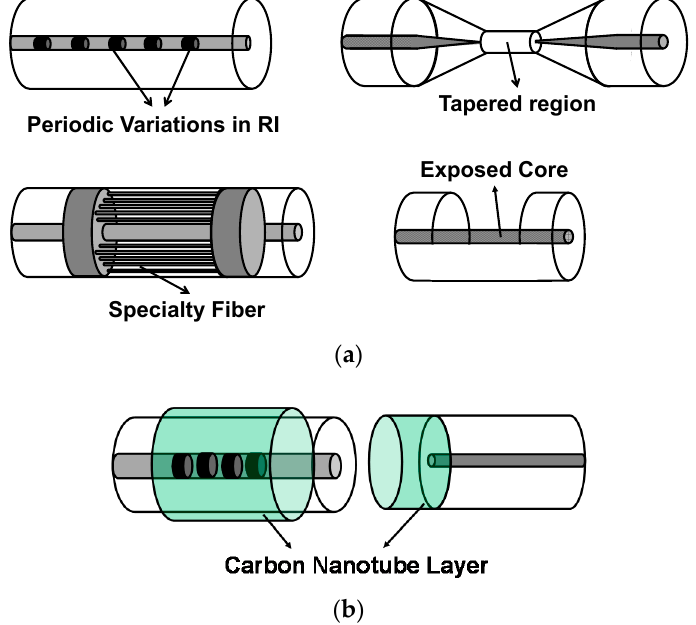
Figure 1. ( a ) Examples of various optical fibre sensing probes. Diagrams show a fibre grating (top left), tapered fibre (top right), optical fibre interferometer (bottom left) and a cladding-removed optical fibre ( b ) Examples of how carbon nanotubes (CNTs) can be deposited onto various optical fibre sensing probes. The diagram on the left shows the deposition of CNTs onto the surface of a fibre grating while that on the right shows the deposition of CNTs onto the end-face of an optical fibre.